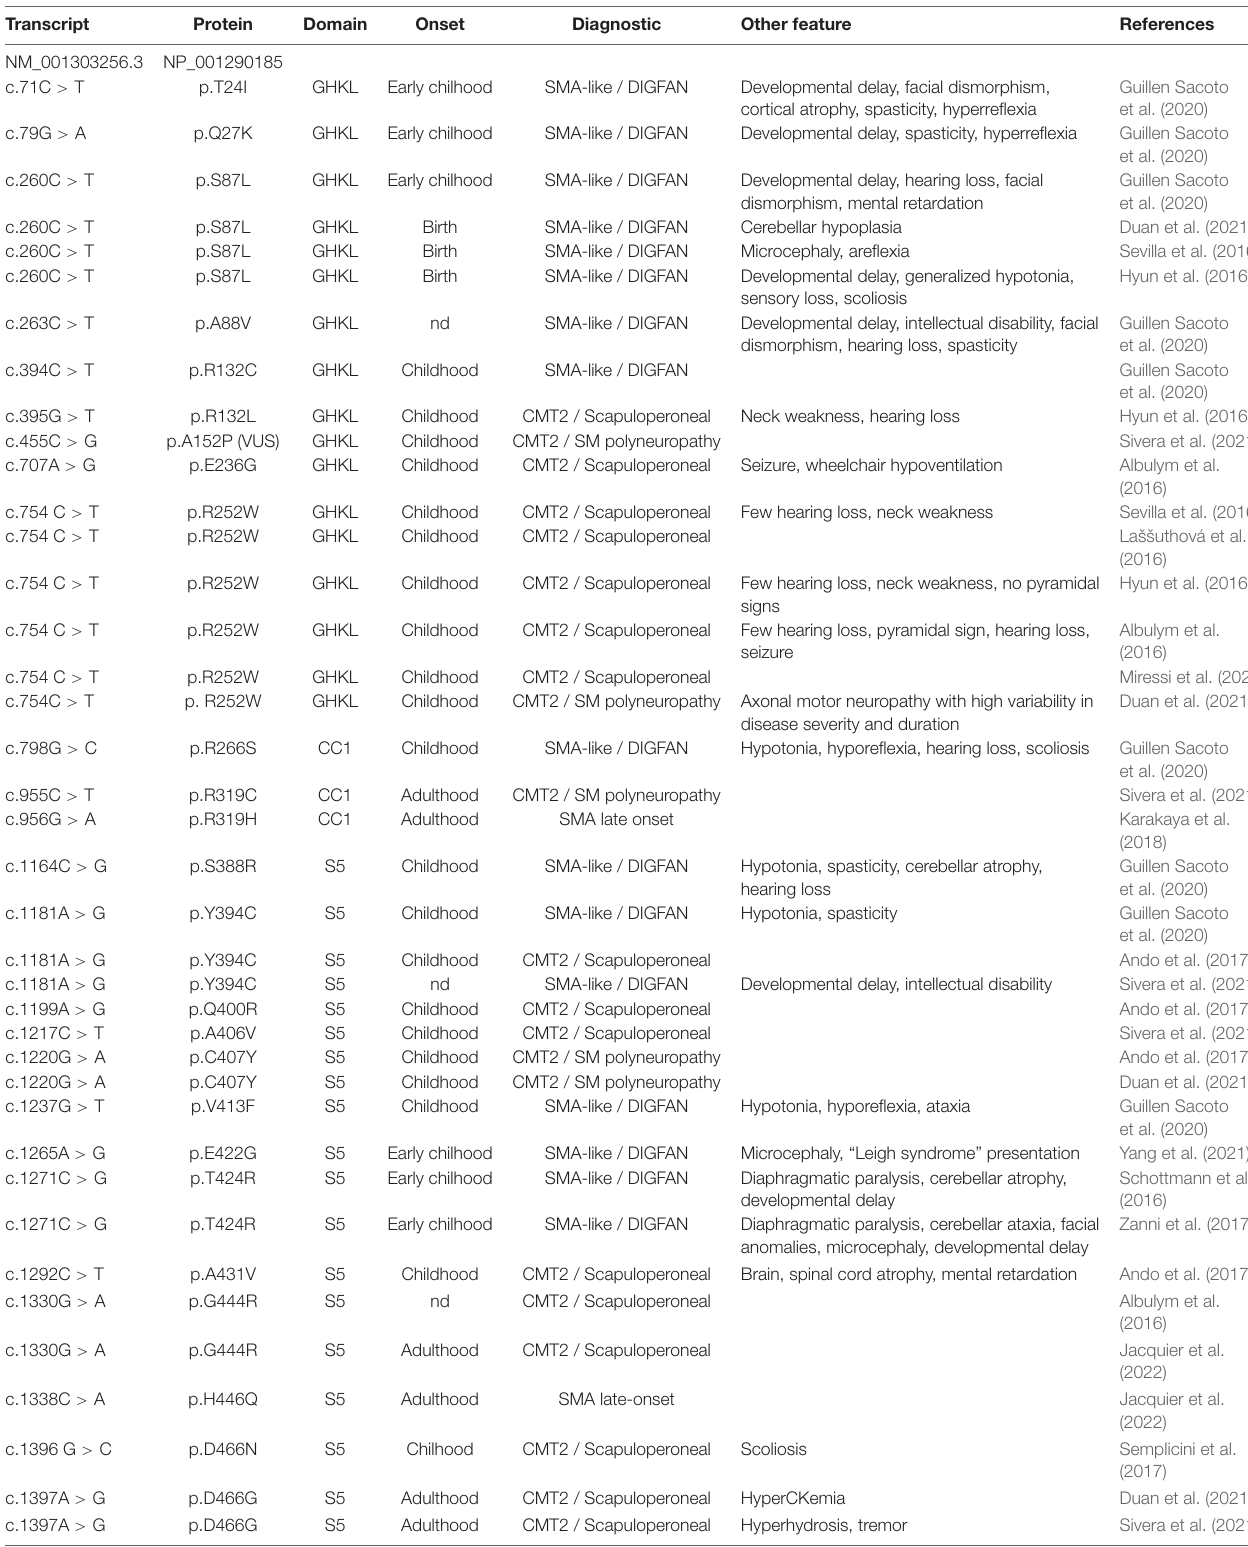
Table describe patient main diagnostic, onset and some additional features for each point mutation in MORC2 transcript (NM_001303256.3) and it consequence on MORC2 protein (NP_001290185).